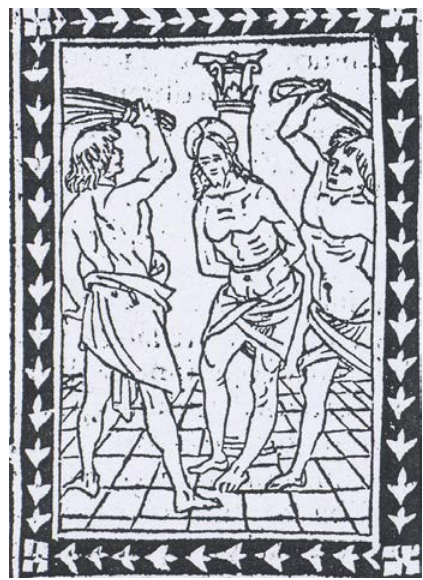
Figure 24 – Girolamo Savonarola, Tractato divoto & utile della Humilità , s.n.t. [ma Firenze, Miscomini, 1493 ca.], f. 3r (BNCF, Cust. C 5). By permission of Ministero per i beni e le attività culturali / Biblioteca Nazionale Centrale. Firenze